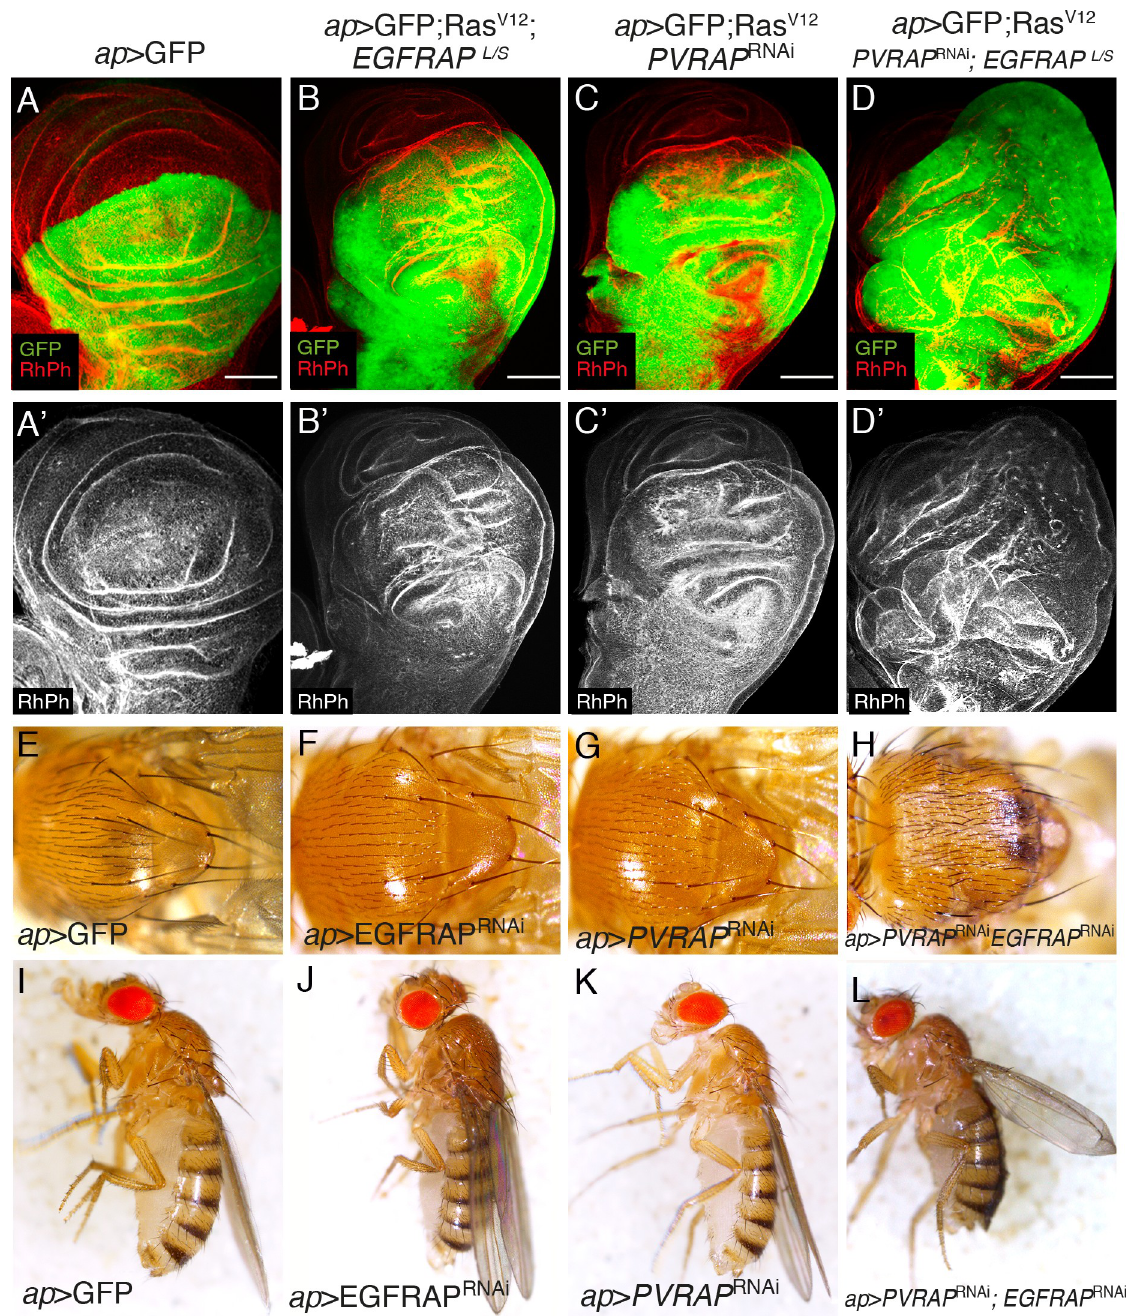
Fig 5. PVRAP downregulation enhances EGFRAP loss of function phenotypes. (A-D’) Maximal projection of confocal images of third instar wing imaginal discs expressing the indicated UAS transgenes under the control of ap -Gal4 stained with anti-GFP (green) and RhPh (red). (E-H) Dorsal view of Drosophila noti of the specified genotypes. (I-L) Images of female flies of the indicated genotypes. Scale bars, 50 μ m (A-C). downregulation of both genes ( ap > EGFRAP RNAi ; PVRAP RNAi ) resulted in ectopic sensory organs in the notum (Fig 5H), a phenotype that resembles increased EGFR activity [14], and blisters in the wing (Fig 5L).